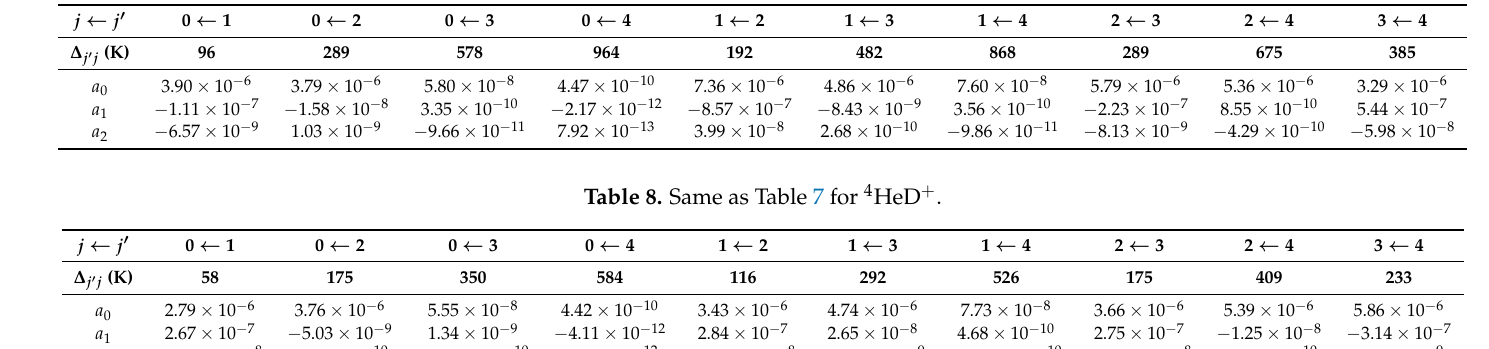
( x ) of Equations (4) and (5) for several pairs of initial and final rotational states for de-excitation j ← j (cid:48) of Table 7. Parameters a 0 , a 1 , and a 2 of the polynomial P fit jj (cid:48) 4 HeH + , with j < j (cid:48) . The probabilities P fit ( x ) for the opposite (excitation) process, j → j (cid:48) , are obtained from P fit ( x ) , multiplying them with the factor ( 2 j (cid:48) + 1 ) / ( 2 j + 1 ) j (cid:48) j jj (cid:48) (see Equation (8)). For convenience, we also specify, in the second line of the table, the threshold energy ∆ j (cid:48) j in units of temperature (K) for the excitation process of the corresponding pair. For the de-excitation processes, ∆ j (cid:48) j = 0.